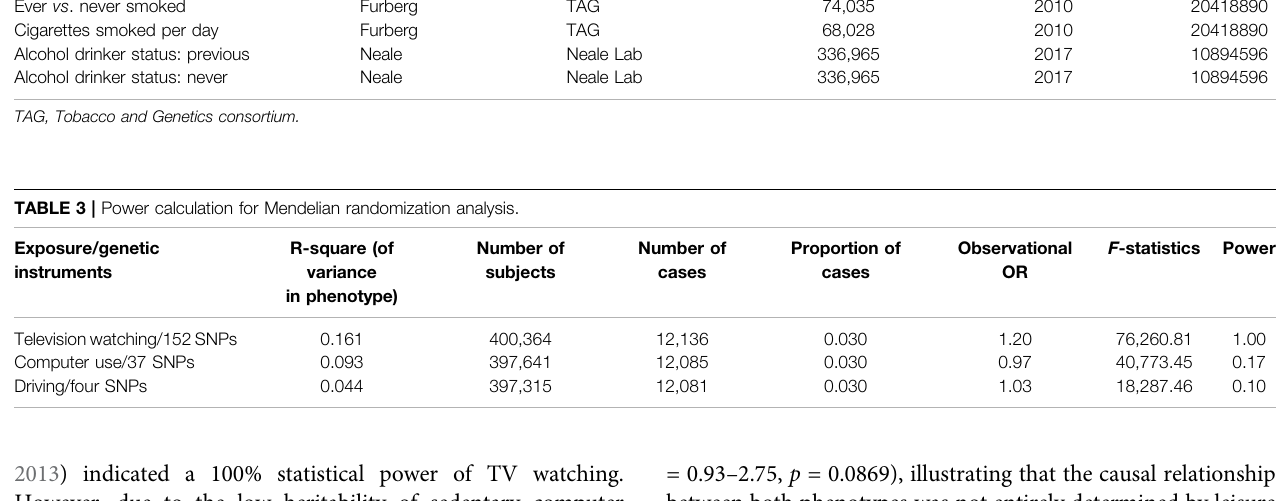
TABLE 2 | Details of studies included in the Mendelian randomization analysis for potential mediators between leisure sedentary behaviors and lung cancer. Traits